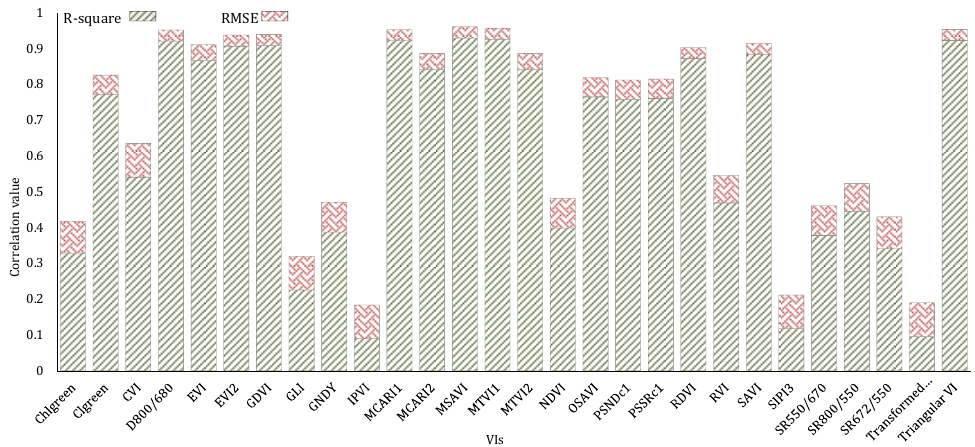
Figure 5. Summary of R-squares and root mean square errors (RMSEs) for each of the Vis (All abrevaitions are mentioned in Table 5).